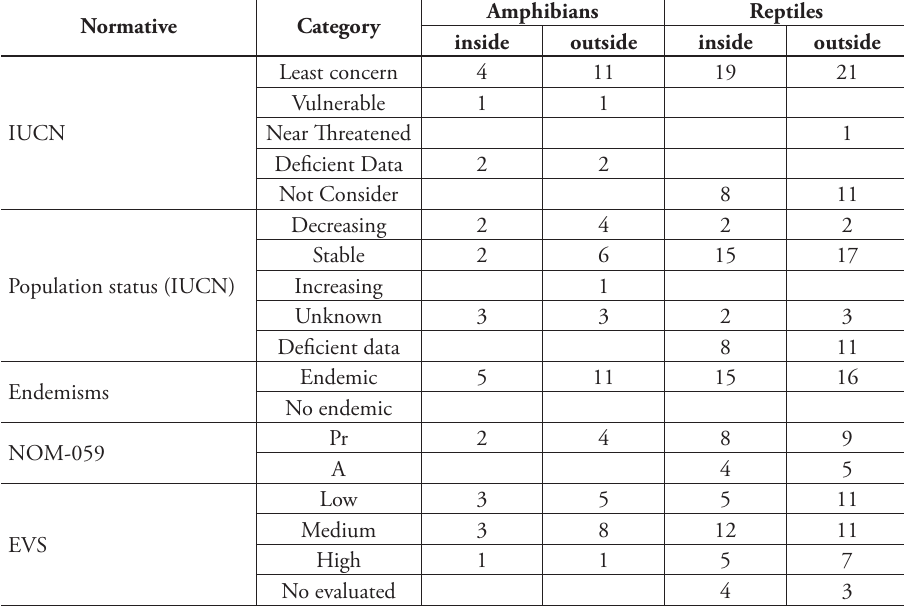
Table 4. Number of species under different risk categories indicated by the national and international regulations (NOM-059, IUCN 2016), and environmental vulnerability index